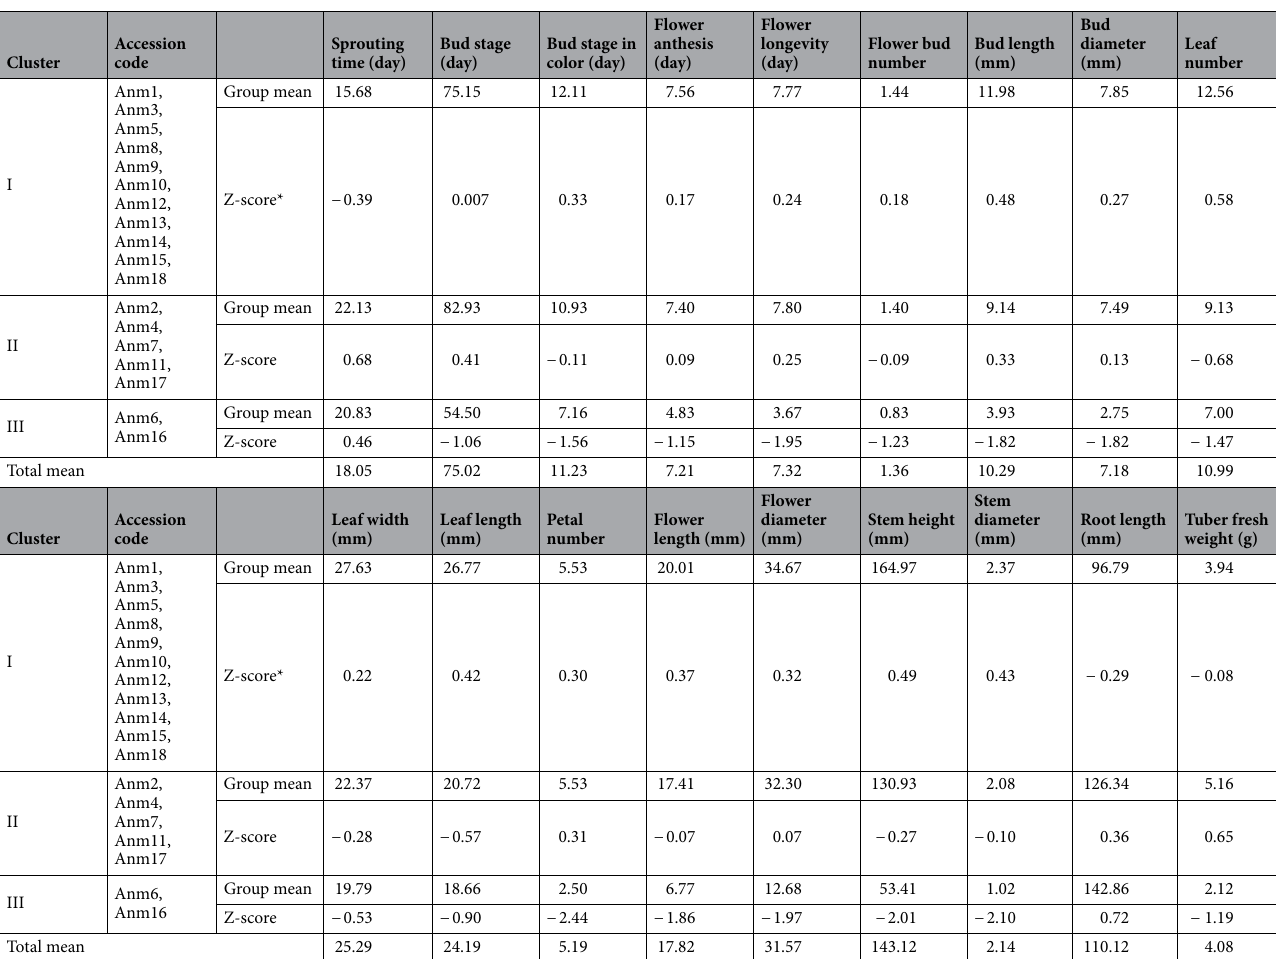
Table 6. Composition of the groups and the distribution of the Anemone accessions in each group based on cluster analysis under GA 3 pre-treatment. *: Z-score was calculated as the difference between the mean of the trait (for each group) and the total mean, divided by the total standard deviation (SD). The highest positive Z-scores are associated with the relative highest value of the variable among the groups. Since the decrease in the value of phenological traits (except for flower longevity on plant) is a desirable feature, the groups with further negative Z-scores were considered to be more superior. Conversely, since the increase in the value of morphological traits is a desirable feature, the groups with further positive Z-scores were considered to be